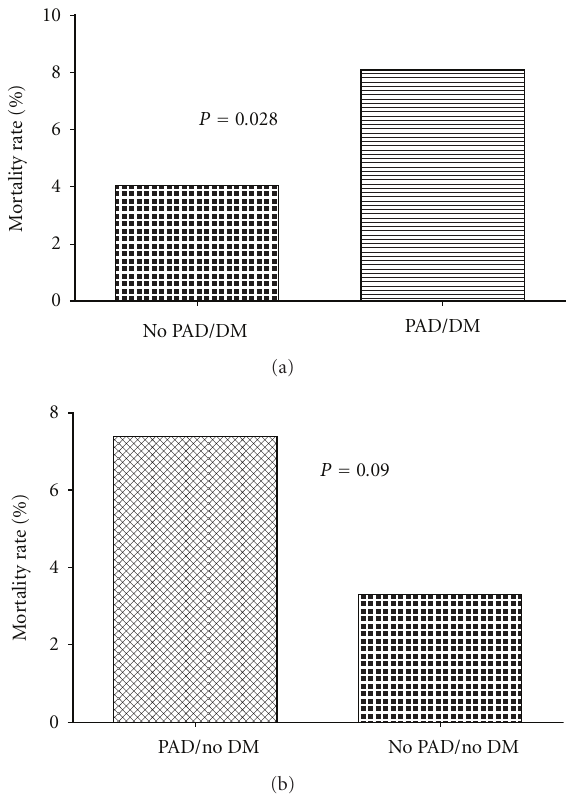
Figure 1: Mortality rate in peripheral arterial disease (PAD) patients presenting with acute coronary syndrome patients and stratified by the diabetic status